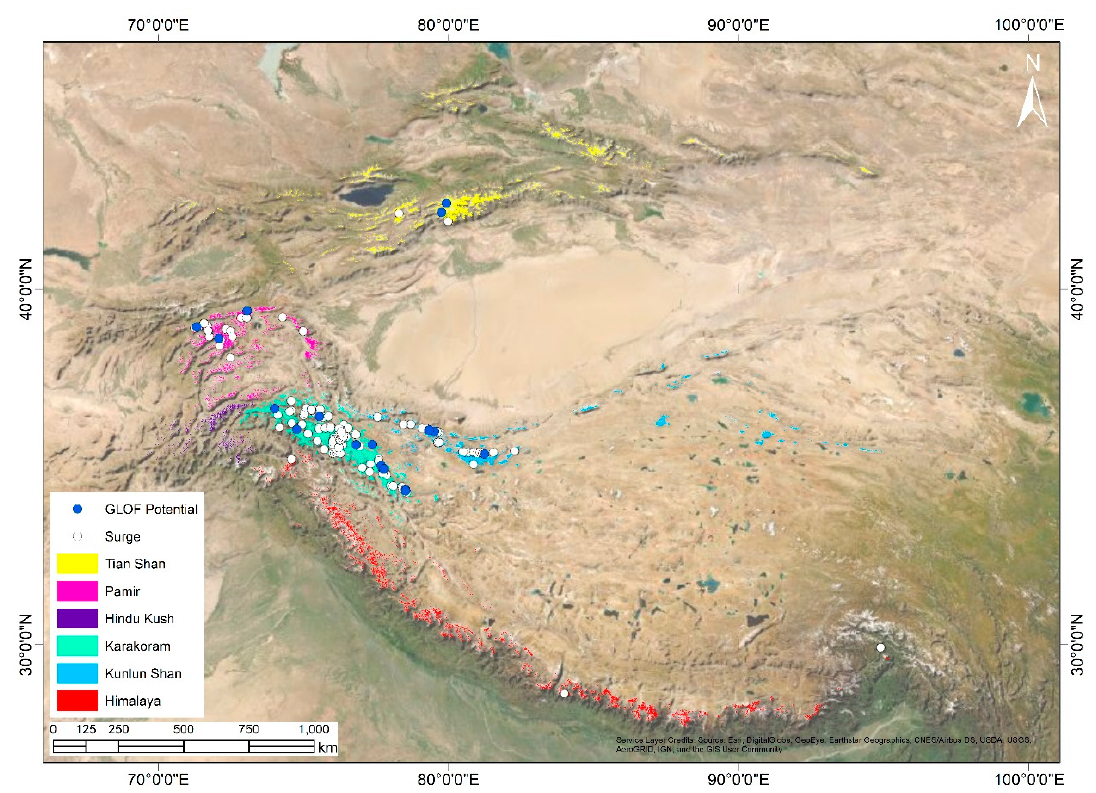
Figure 8. Surging glaciers identified with the potential to block glacier valleys, encourage glacier lake formation, and increase the glacier lake outburst flood (GLOF) hazard.